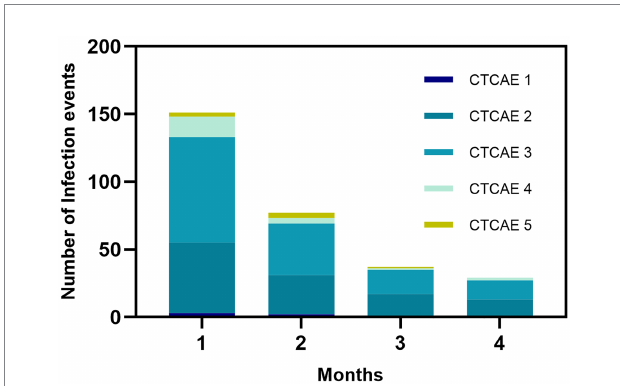
FIGURE 2 Infection events and grading within the first 4 months. The severity of infection was evaluated using the Common Terminology Criteria for Adverse Events v5.0 (CTCAE) published by the National Cancer Institute